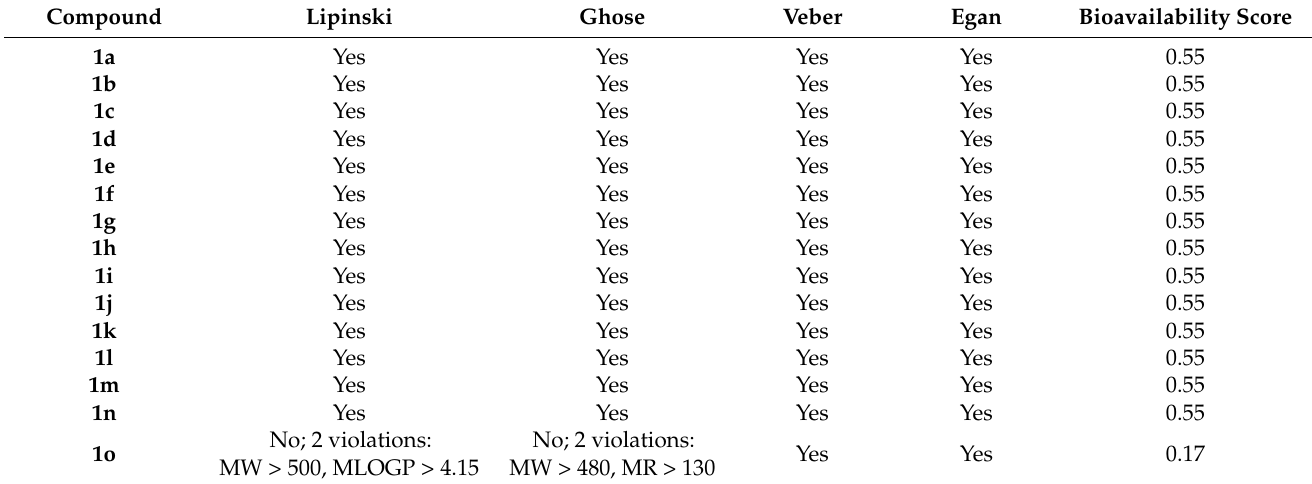
Table 5. The drug-likeness features according to Lipinski, Veber, Ghose, and Egan rules.